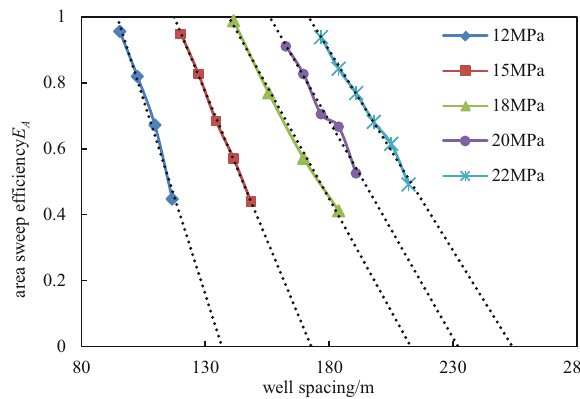
Fig. 14 Curves of well spacing and areal sweep efficiency in thin and poor layer